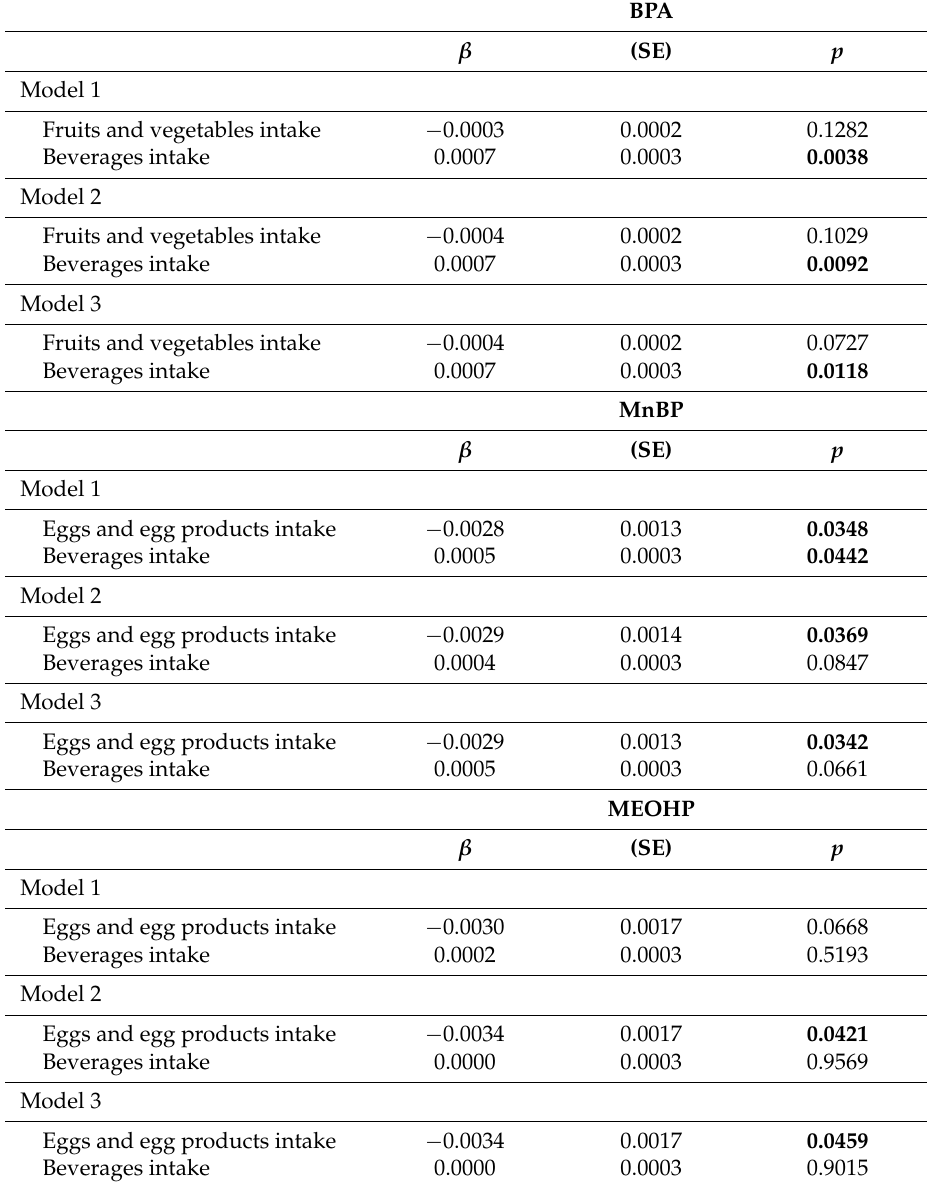
Table 5. Coefficients from multiple regression analysis between food intake and urinary BPA and phthalates concentration ( n =